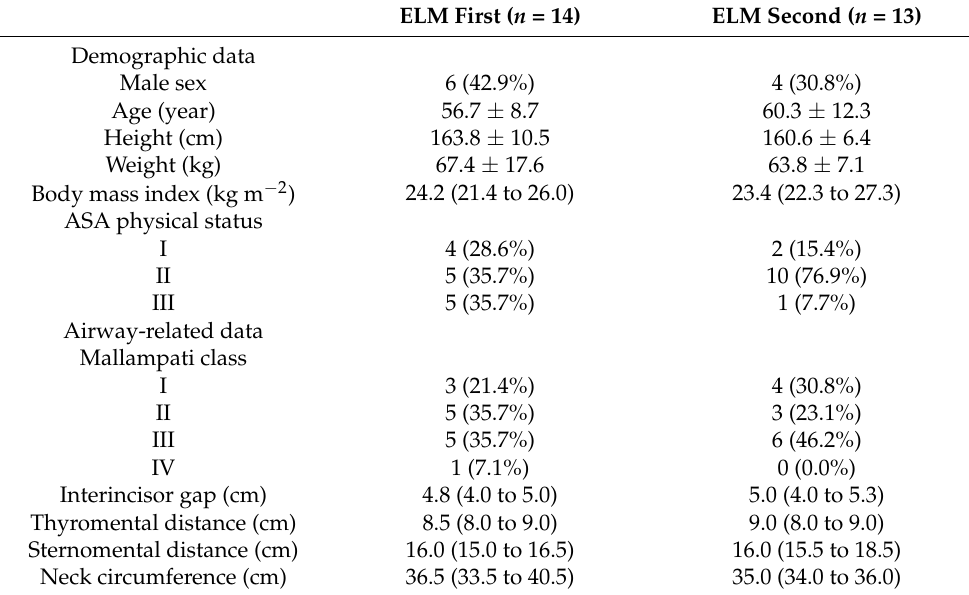
Table 1. Patient